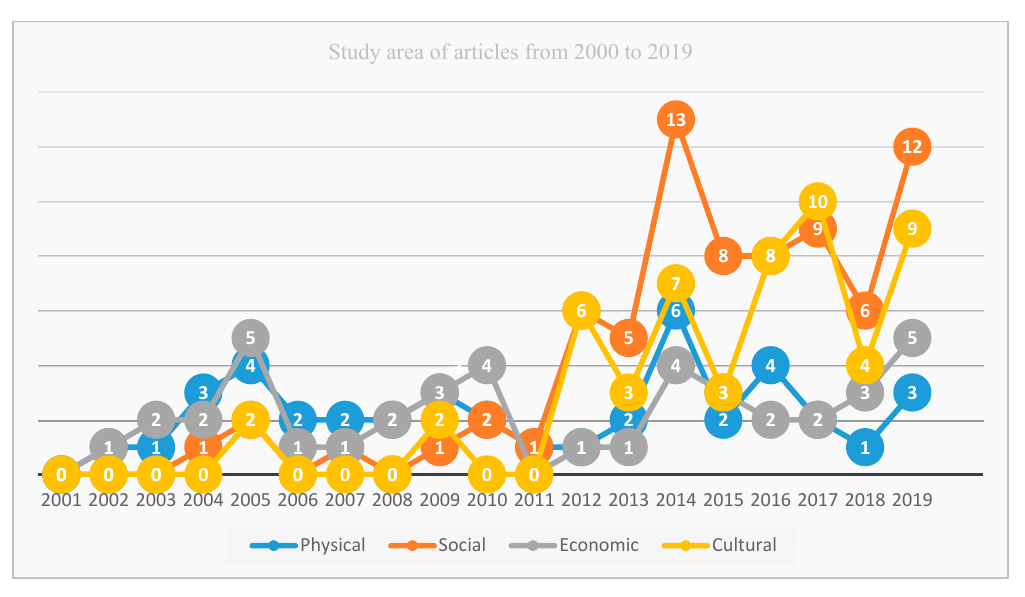
Figure 4. Study area of articles from 2000 to 2019.